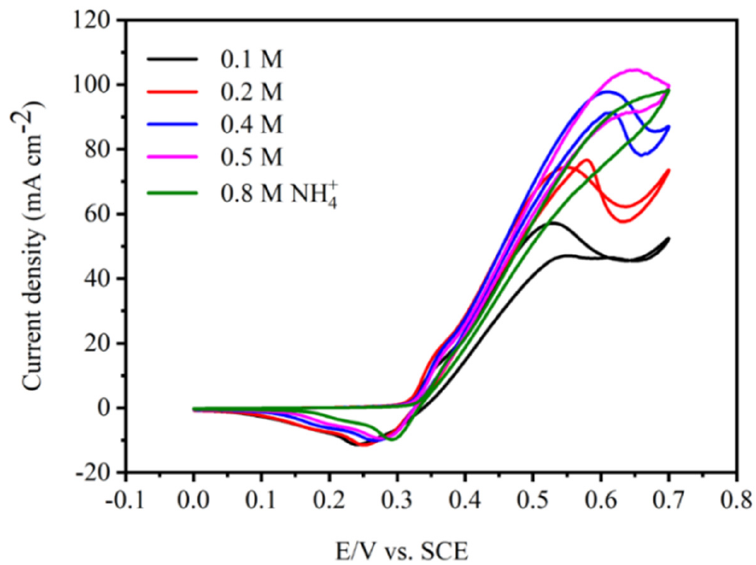
Figure 7. The comparison of CV curves collected on the NiCuOOH-NF electrode at scanning rate of 20 mV s − 1 in different NH 4 + concentration in 2 M NaOH.